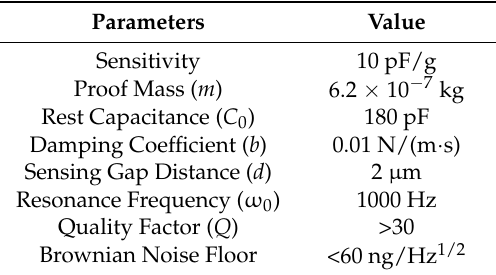
Figure 1. Vacuum-packaged bulk micro-accelerometer and equivalent bridge model. Table 1. Parameters of the high- Q